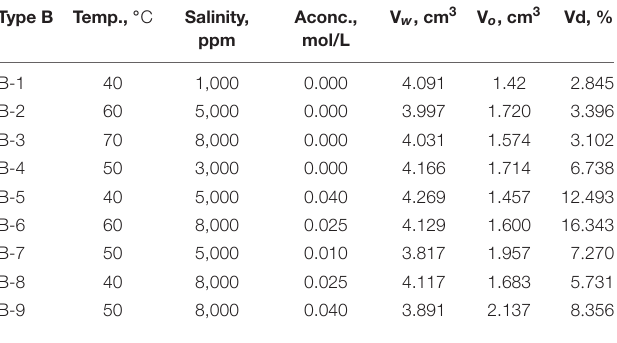
TABLE 4 | Na 2 CO 3 orthogonal test phase migration volume fraction of 2-phase distribution cases.